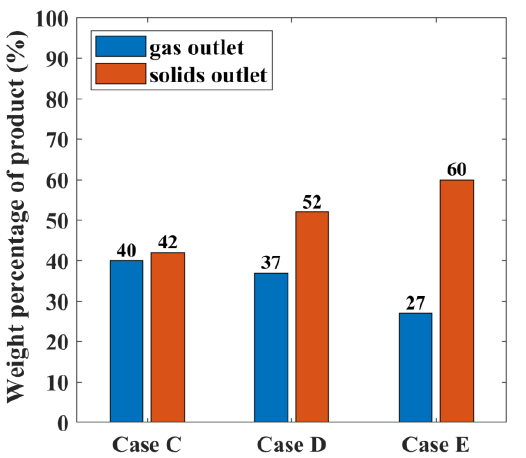
Figure 12. Comparison of weight percentage (%) of product recovered at the outlets for cases C – E.